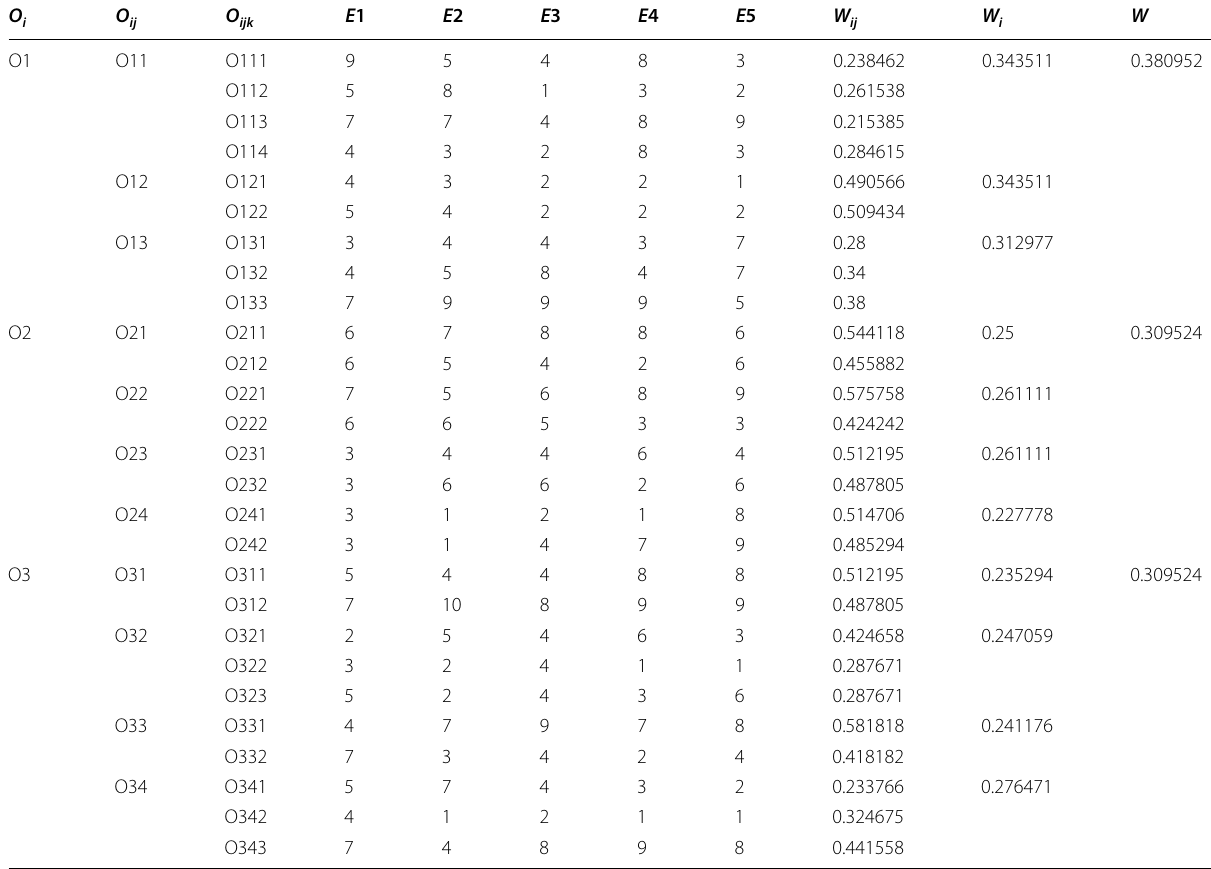
Table 4 Normalised weights and experts’ rating of the case